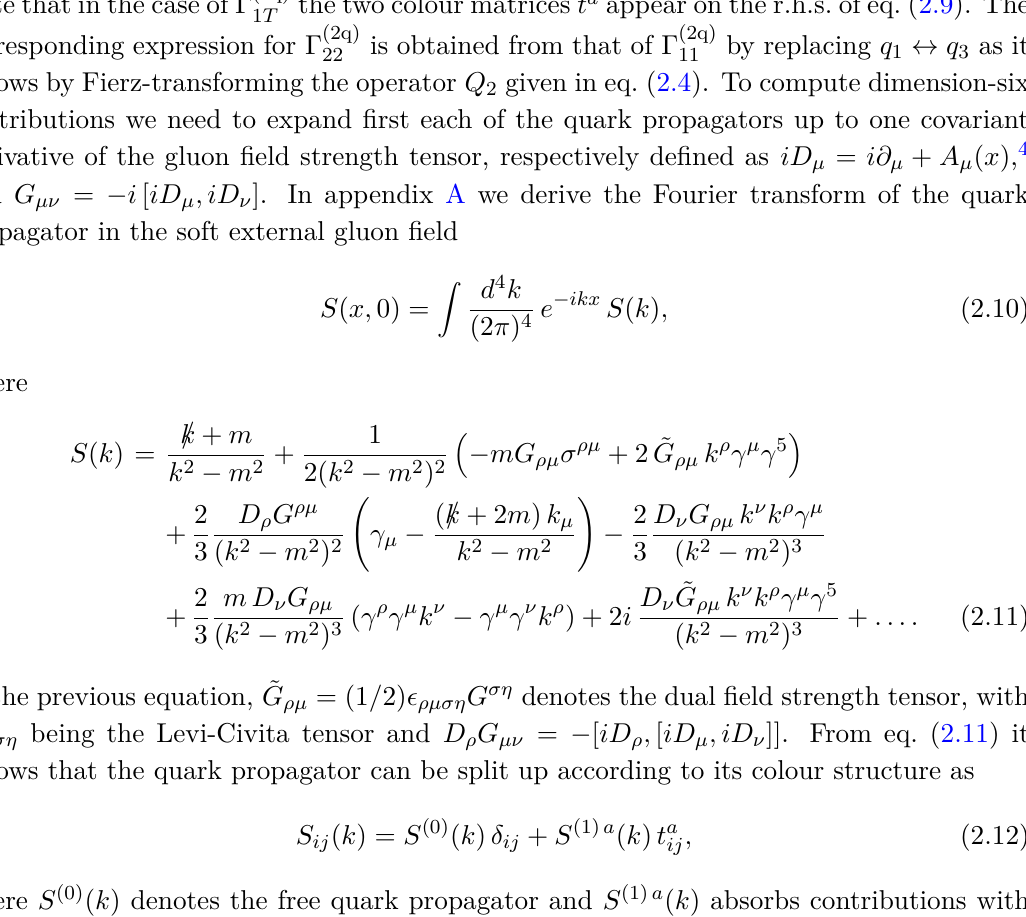
) , and it is thus b